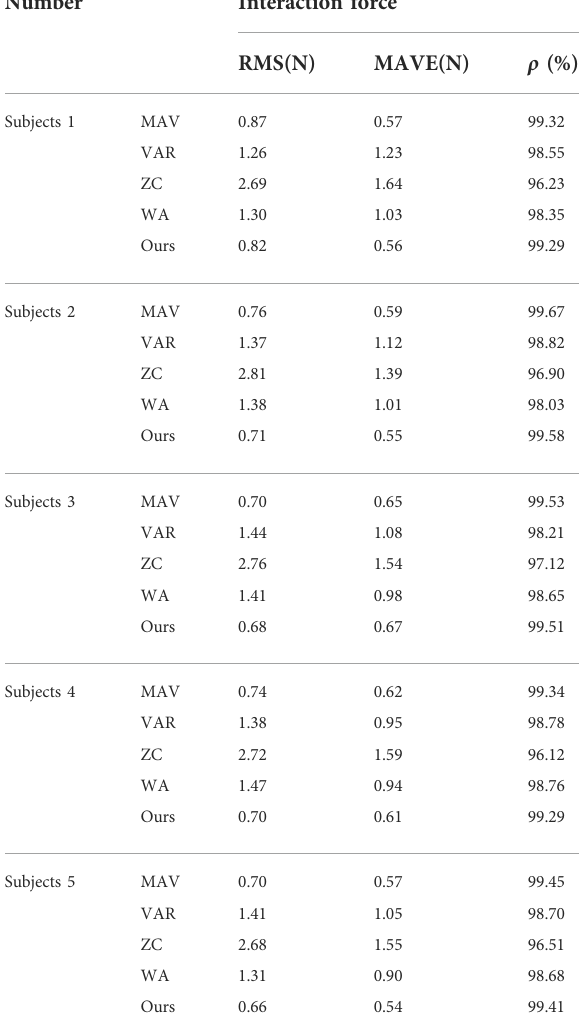
TABLE 4 Prediction time comparison of different algorithms.